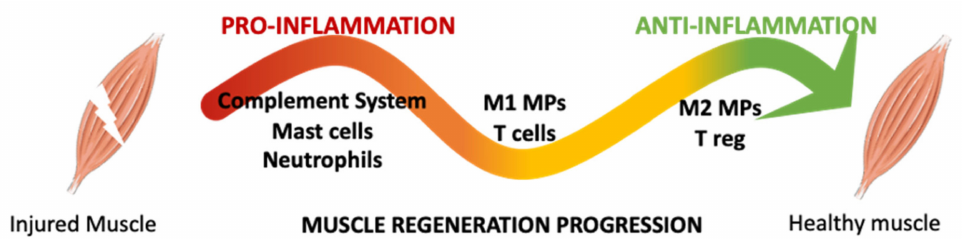
Figure 2. Schematic representation of the events succession related to immune cells during the SkMR. In early phase, the innate immune response activates the complement system, mast cells, and neutrophils. All these cells recruit monocytes at the injured site that mature in macrophages (MPs) with first a pro-inflammatory phenotype (M1-MPs) and then an anti-inflammatory phenotype (M2-MPs). These cells cooperate with local stem cells to promote tissue repair and